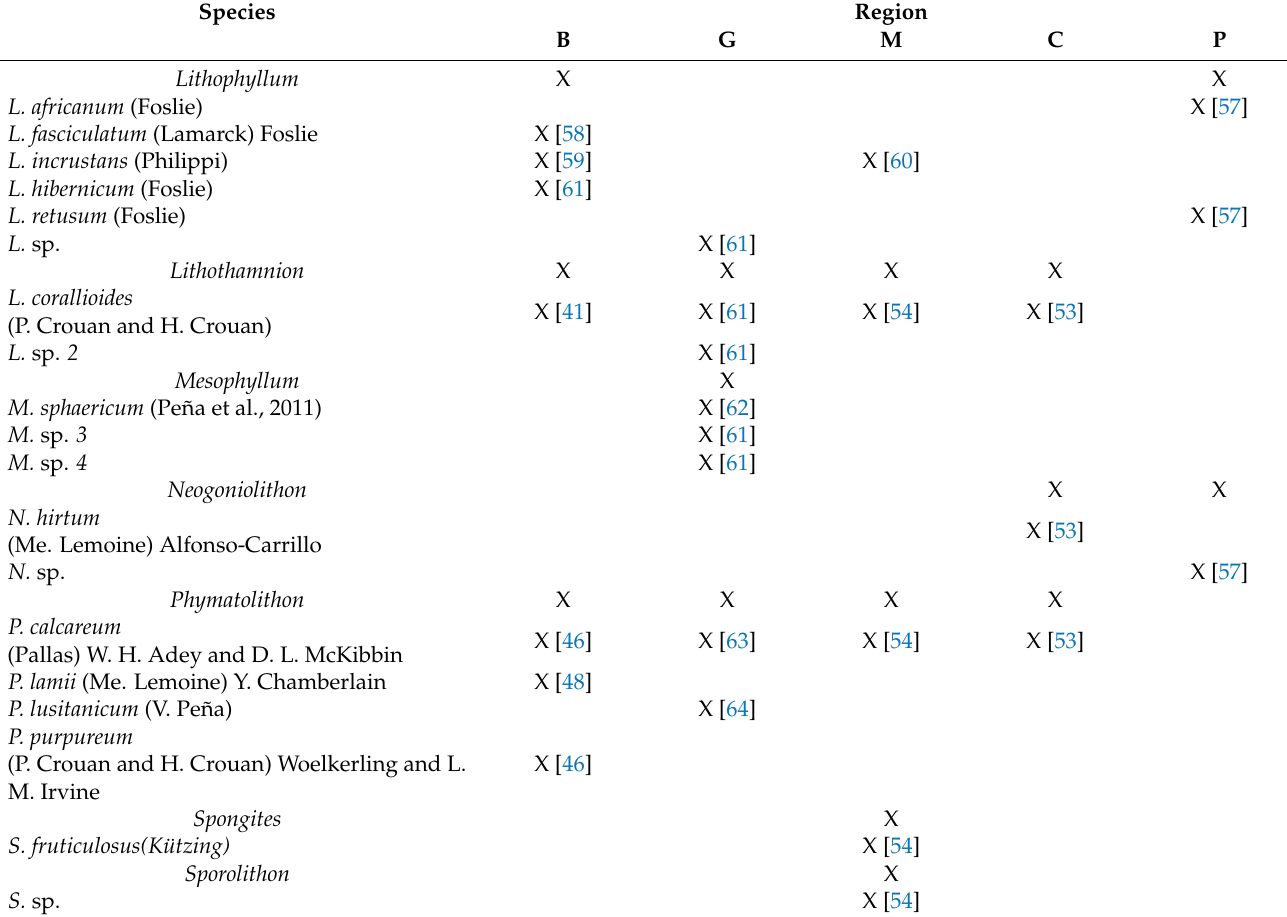
Table 1. Rhodolith species (according to the literature) and their distribution across the Eastern Atlantic Ocean. B = Brittany, G = Galicia, M = Madeira, C = Gran Canaria, and P = Principe Island. The superscript letters indicate the references that cite the species of rhodoliths in each region. Species Region B G M C P X X X